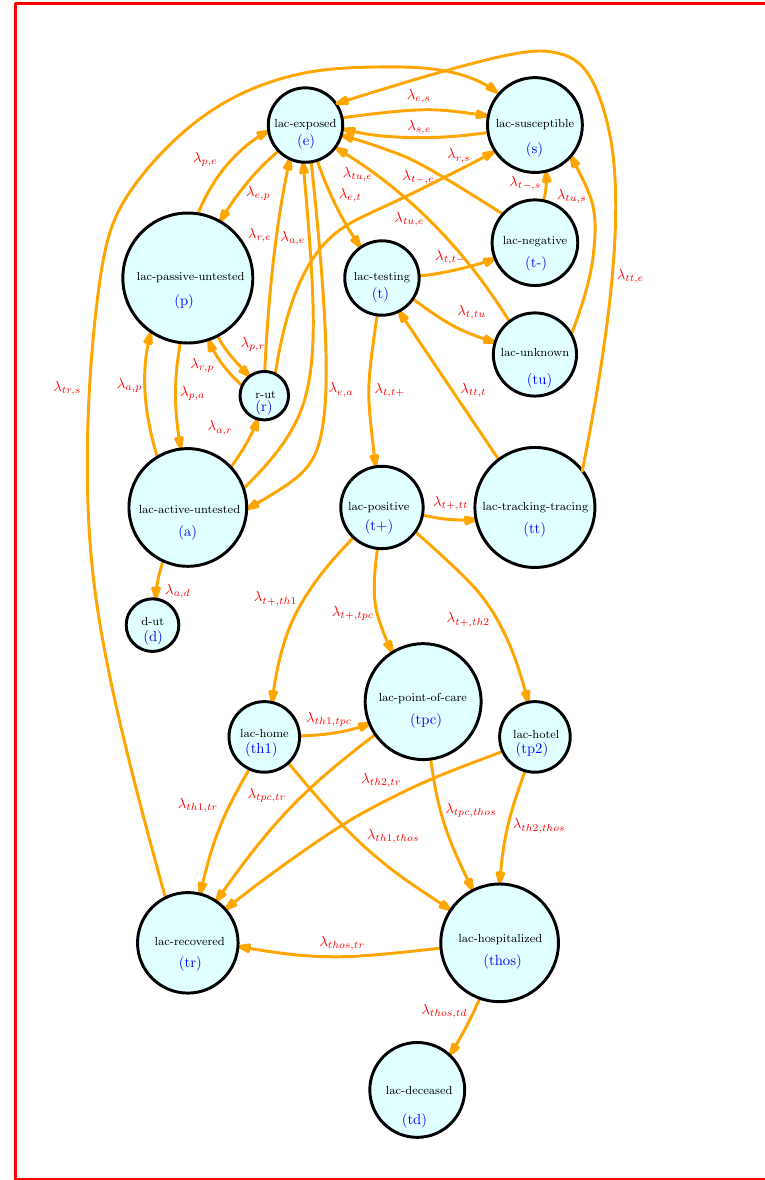
Figure 7. Intra-dynamics at a given location with untested and tested options. Home, hotel, point-of-care isolation. l.a.c=location(l)-age (a)-pre-existing condition (c), gender, height, family size, economic